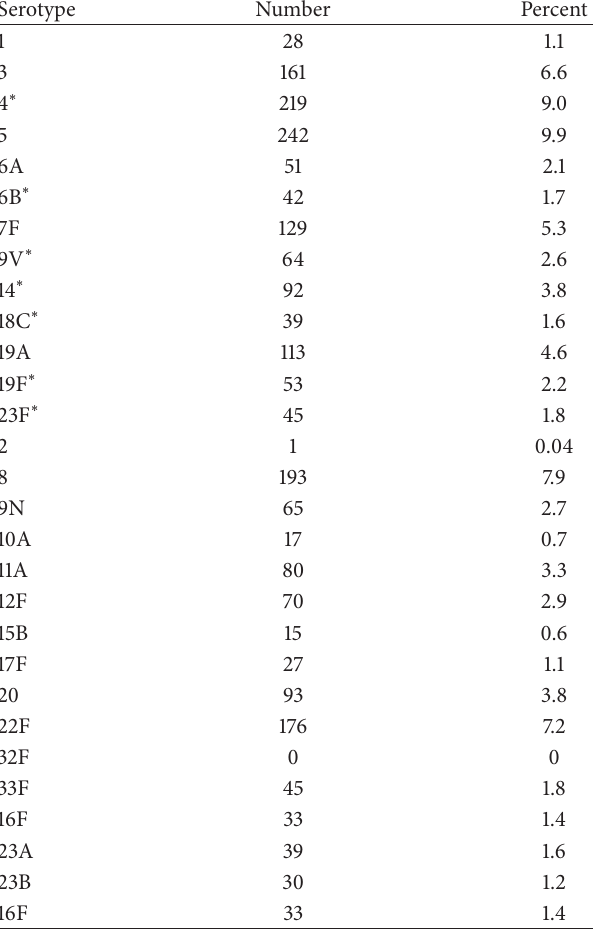
Table 7: Selected Streptococcus pneumoniae serotypes from 2401 patients (data missing for 34 patients due to nonviable